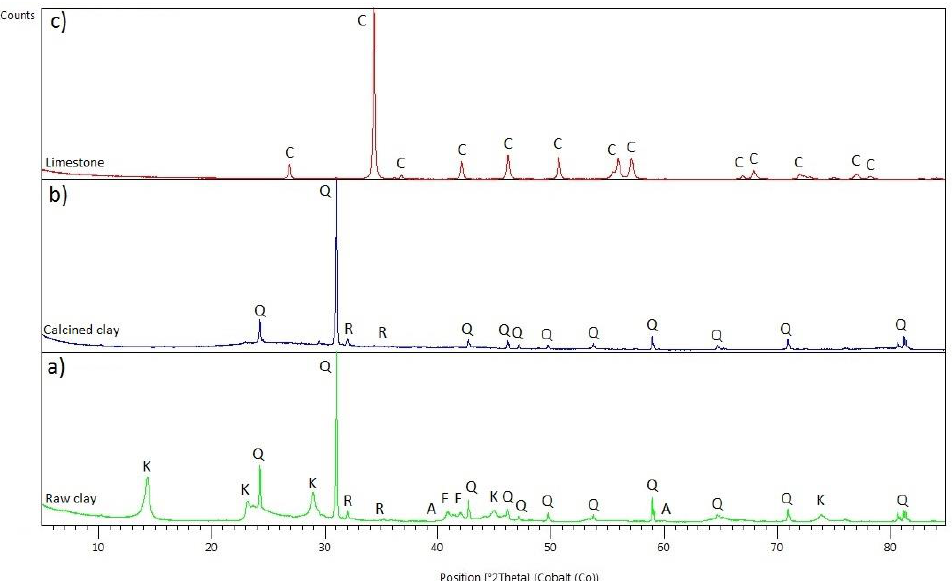
Figure 2. XRD pattern of ( a ) raw and ( b ) calcined clay and ( c ) limestone. Q: quartz; K: kaolinite; R: rutile; F: feldspar; A: anatase; C: calcite.